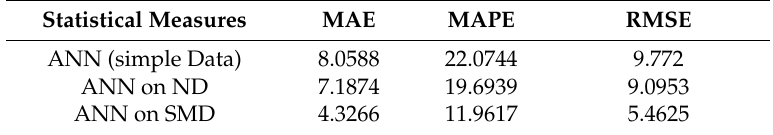
Table 4. Average values of MAE, MAPE, and RMSE of above three tables. Statistical Measures MAE